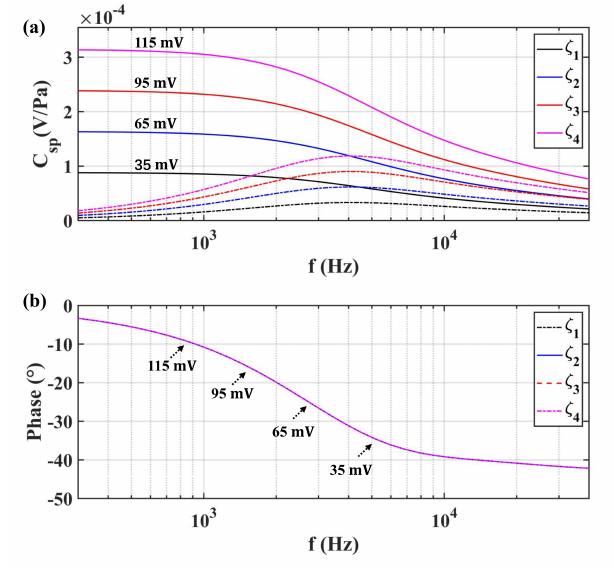
Figure 13. Frequency dependence of C sp with different zeta potentials for B3: ( a ) the amplitude of C sp ; ( b ) the phase of C sp .